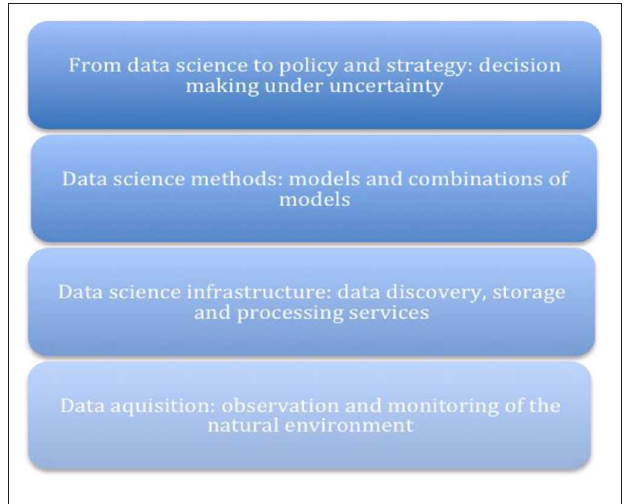
FIGURE 3 | Key data science